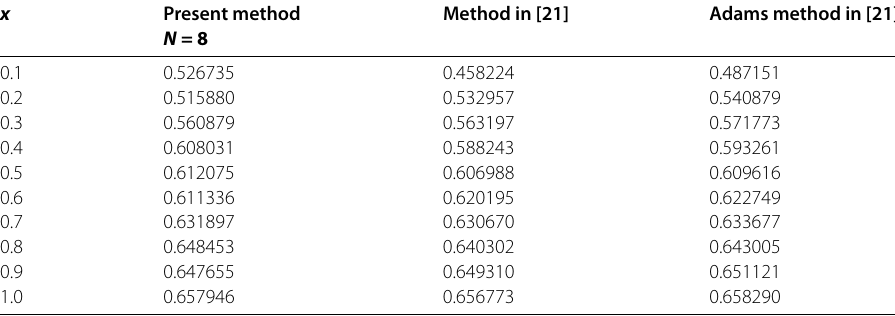
Table 1 Comparison of the numerical solutions with the other methods for α = 1/4 of Example 2